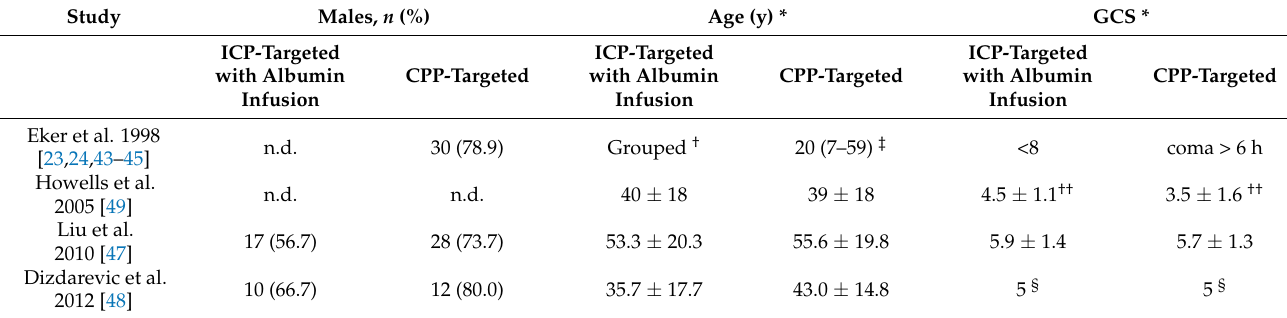
Table 3. Baseline data of the patients in the meta-analysis.